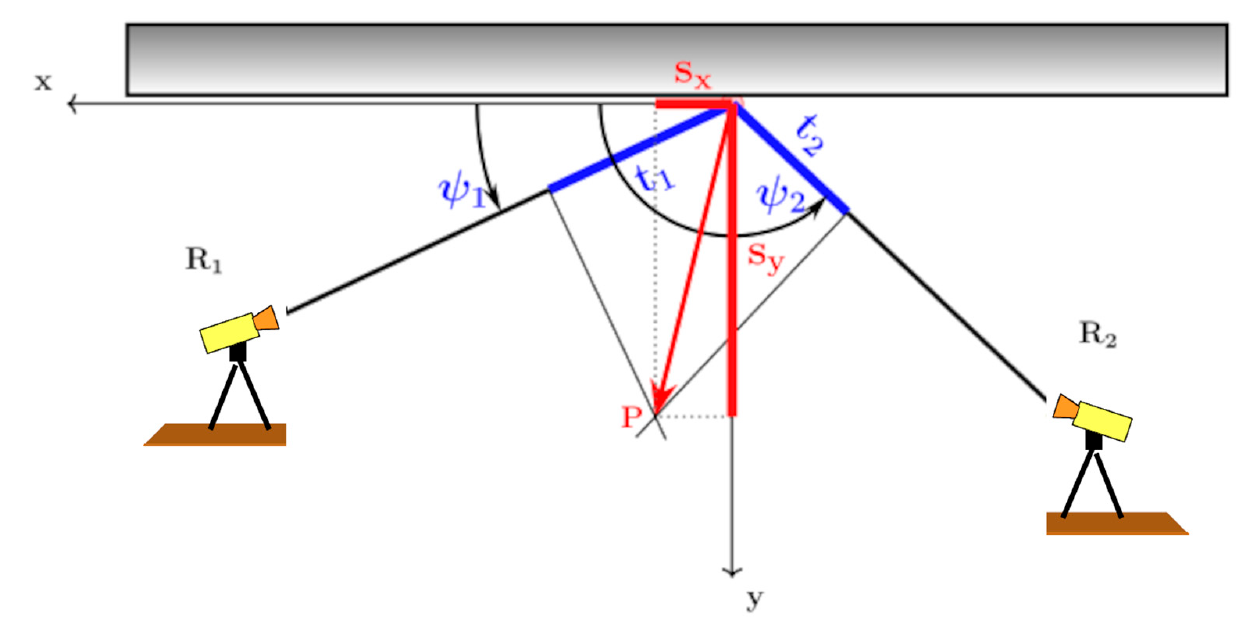
Figure 4. Relationship of displacement vector [ s X , s Y ] to measured LOS displacements t 1 , t 2 and , 𝑠 ] to measured LOS displacements 𝑡 (cid:3025) (cid:3026) vertical angles ψ 1 , ψ 2 from radars R 1 , R 2 to the monitored , 𝜓 from radars 𝑅 , 𝑅 to the monitored point. (cid:2869) (cid:2870) (cid:2869) (cid:2870)